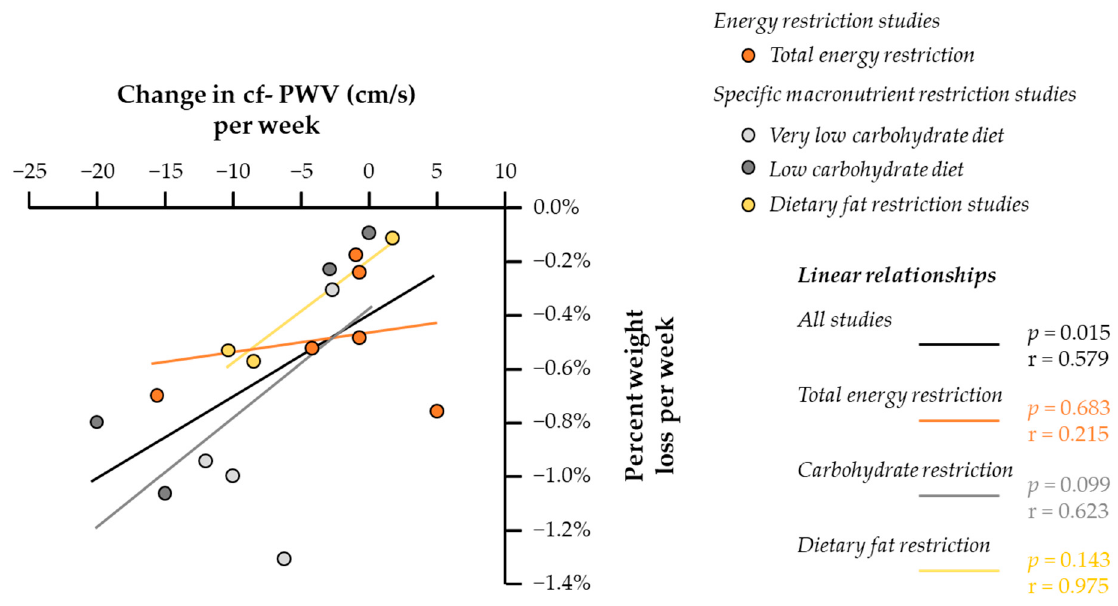
Figure 3. Relationship between diet-induced percent weight loss and arterial stiffness calculated per week. Legend: Each data point represents each study included in the analysis. Two studies were excluded because they did not report percent weight loss/were not able to make calculations because of missing baseline body weight. The change in cf-PWV was divided by the duration of the study to estimate the cf-PWV per week. Similar calculations were performed for weight loss. Blackline represents all studies included in the analysis. Orange line and dots represent studies with total energy restriction; grey line, and dots represent studies that restricted only carbohydrates, darker grey dots represent moderate restriction and lighter grey dots represent very low-carbohydrate diets. Yellow line and dots represent studies that restricted dietary fat. Abbreviations: cf-PWV, carotid-femoral pulse wave velocity.